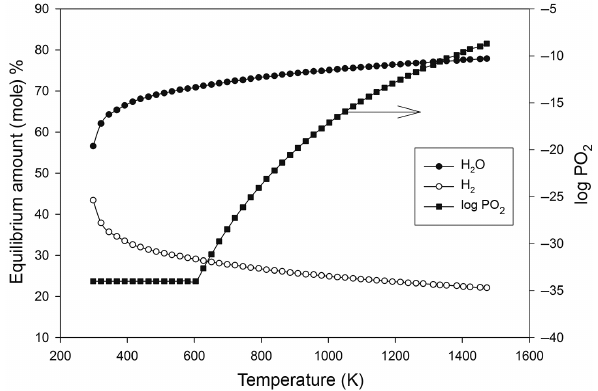
Figure 6: Effect of temperature on the gas composition and log P O at a reductant to ore ratio of 0.558 kmol/100